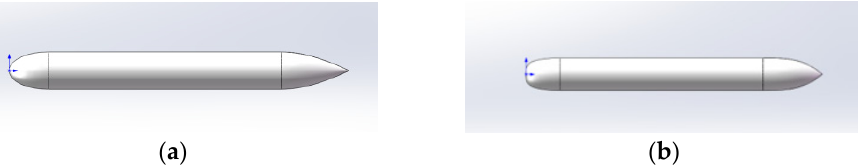
Figure 7. Three-dimensional sketch of two kinds of hull models, the model with p = 2; θ = 25° ( a )